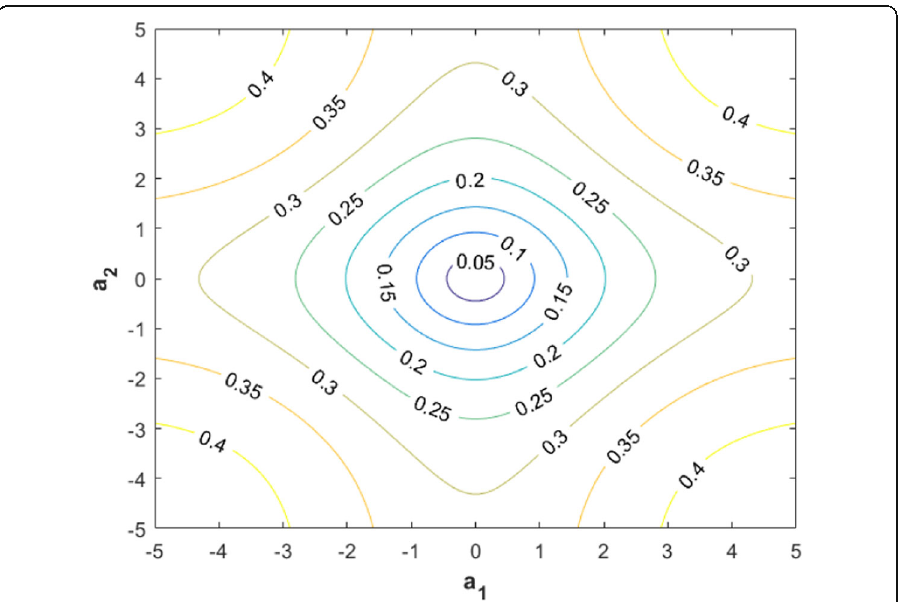
Fig. 4 The contours of CIM σ =